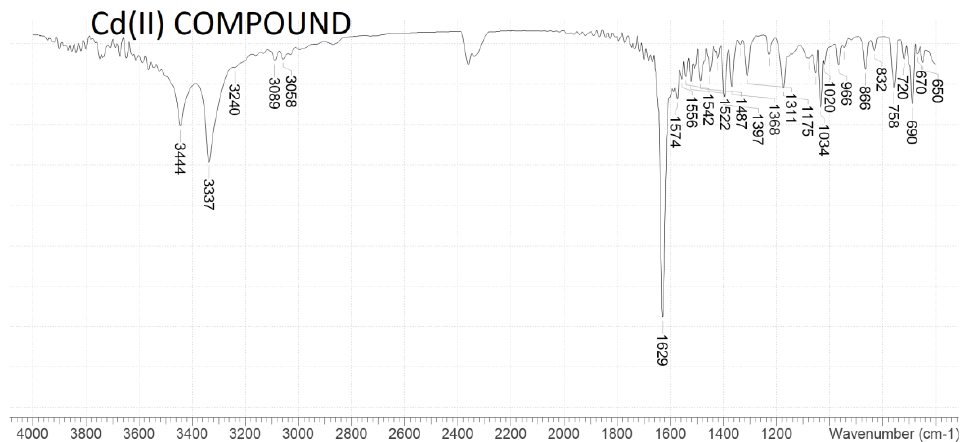
Figure 3. FTIR spectra of free organic ligand and studied coordination compounds.